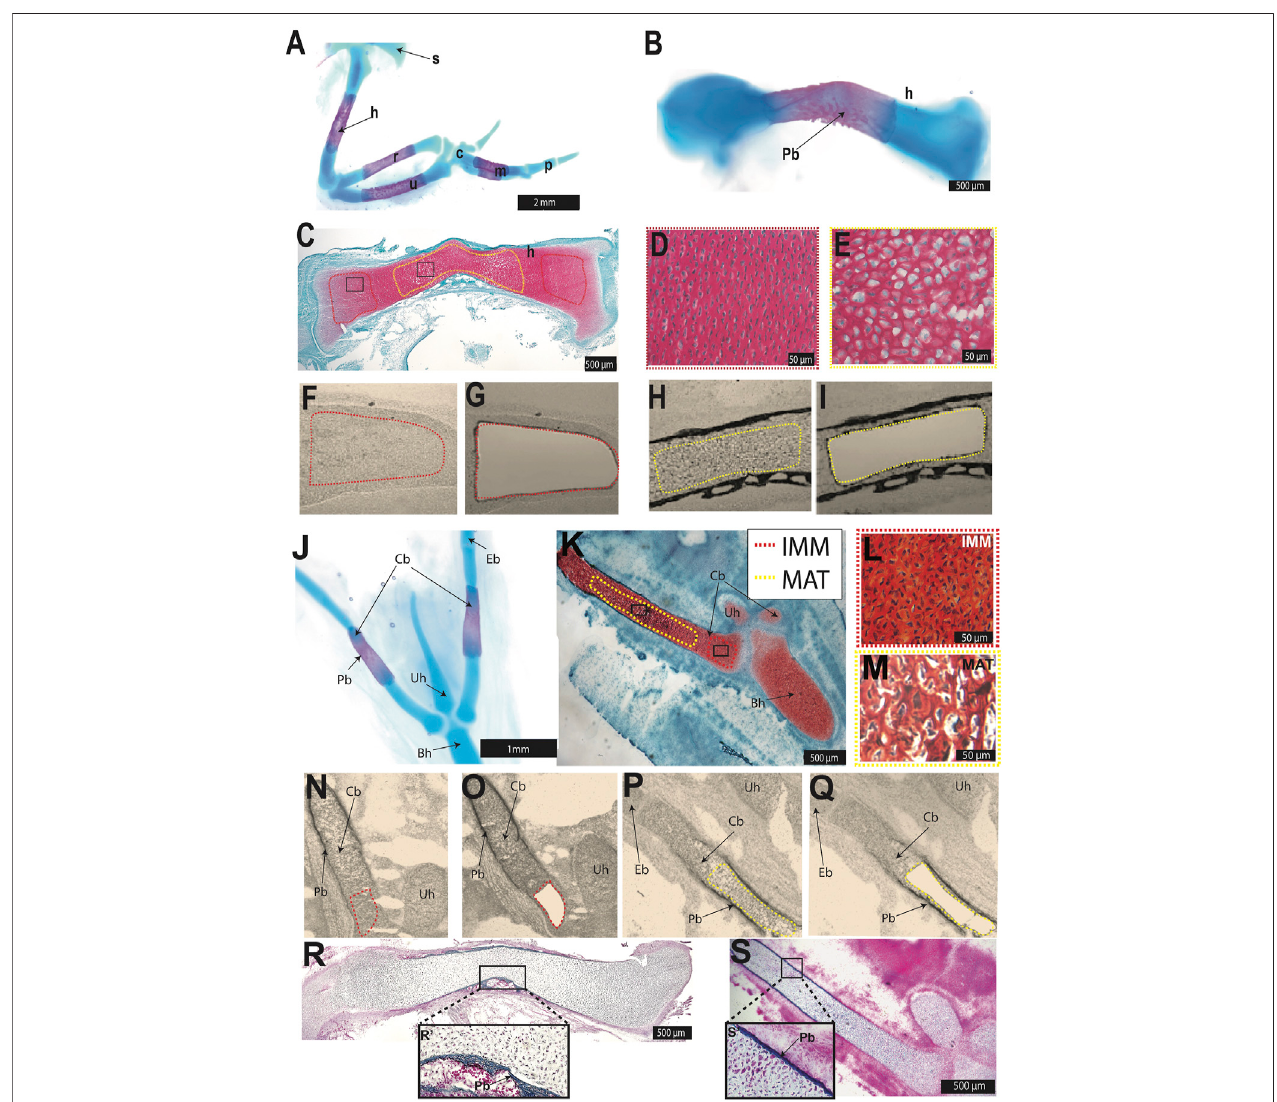
FIGURE1| LasercapturemicrodissectionwasusedtoisolatechondrocytesfromthechickHH36humerusandceratobranchial. (A,B,J) Whole-mountAlcianblue and Alizarin red staining identi fi ed cartilage and perichondral bone in chondral bones of the chick forelimb (A,B) or hyoid (J) . (C,K) Safranin O-stained section of HH36 humerus or ceratobranchial highlighted immature (IMM, red dotted outline) and mature cartilage (MAT, yellow dotted outline). (D,E,L,M) High-magni fi cation images of IMM (D,L) andMAT (E,M) fromblackboxesin (C) or (K)(F – I,N – Q) UnstainedsectionsofHH36chickhumerusorceratobranchialbefore (F,N) andafter (G,O) laser captureofIMM,andbefore (H,P) andafter (I,Q) lasercaptureofMAT. (R,S) Trichrome-stainedsectionofHH36humerusorceratobranchialshowedAnilinebluestaining ofbonematrixinperichondralbone.Abbreviations:Bh=basihyal;c=carpal;Cb=ceratobranchial;Eb=epibranchial;h=humerus;IMM=immaturechondrocytes;m= metacarpals; MAT = mature chondrocytes; p = phalanges; Pb = perichondral bone; r = radius; s = scapula; u = ulna; Uh = urohyal.